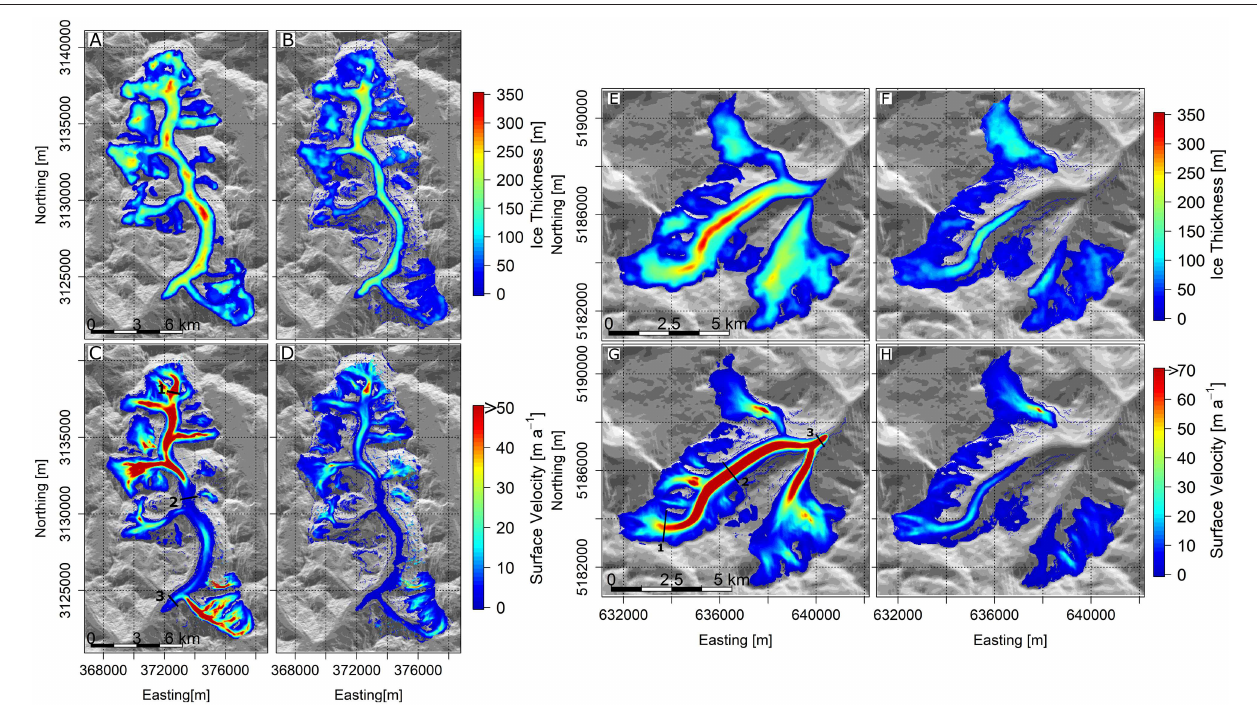
FIGURE 6 | Ice thickness and surface velocity fields of Langtang Glacier (A–D) and Hintereisferner (E–H) , showing modeled ice thickness/velocity in 1850/1860 (A,C,E,G) and 2016 (B,D,F,H) for cold/wet (Langtang Glacier) and cold/dry climate conditions (Hintereisferner). The numbers denote the locations of the transects at 2 (2) km, 6 (9) km, and 10 (17) km of the glacier head of Hintereisferner (Langtang Glacier). These transects are used for the modeled velocities given in Figures 5 , 8 .